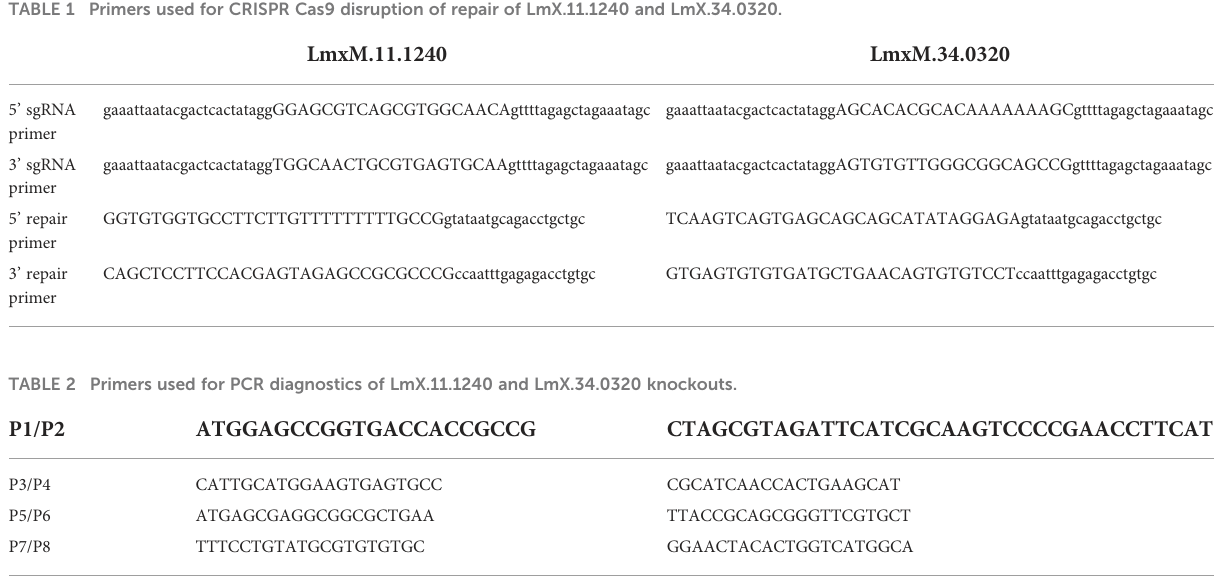
TABLE 1 Primers used for CRISPR Cas9 disruption of repair of LmX.11.1240 and LmX.34.0320.